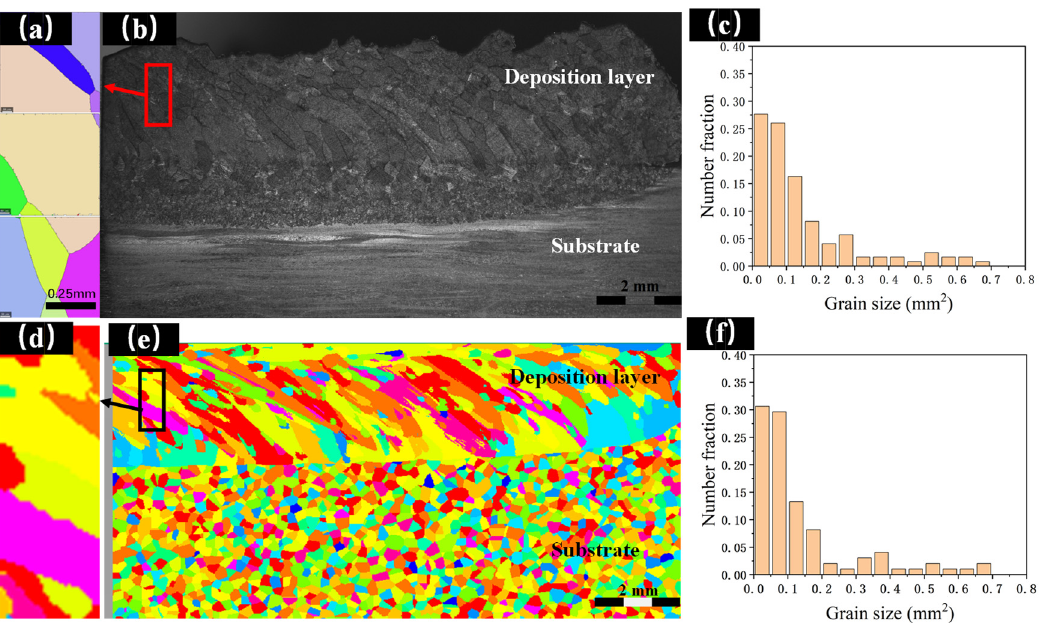
Figure 11. Transverse cross-section of solidification microstructure during single-track deposition: ( a ) EBSD prior β phase reconstruction diagram; ( b ) experimental grain morphology; ( c ) experimental grain size distribution; ( d ) local simulated grain morphology; ( e ) simulated grain morphology; ( f ) simulated grain size distribution.